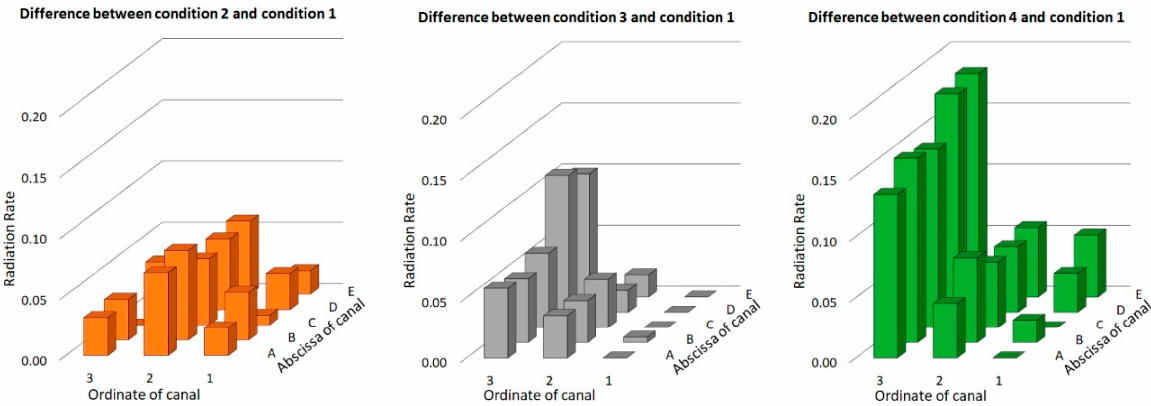
Figure 8. Difference of the partial means between conditions 2, 3 and 4, with respect to the standard condition 1.